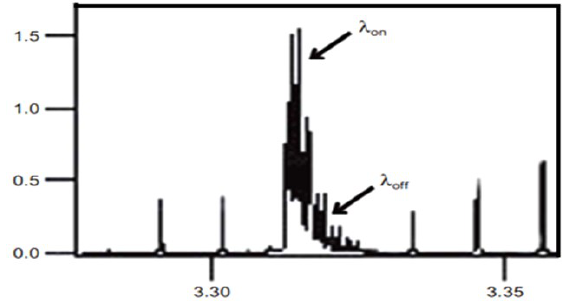
Fig. 2: Methane absorption spectra. Two selected lines – λ on and λ off –in the figure (source: HITRAN2012). Fig. 3: Experimental results of the diurnal variation of